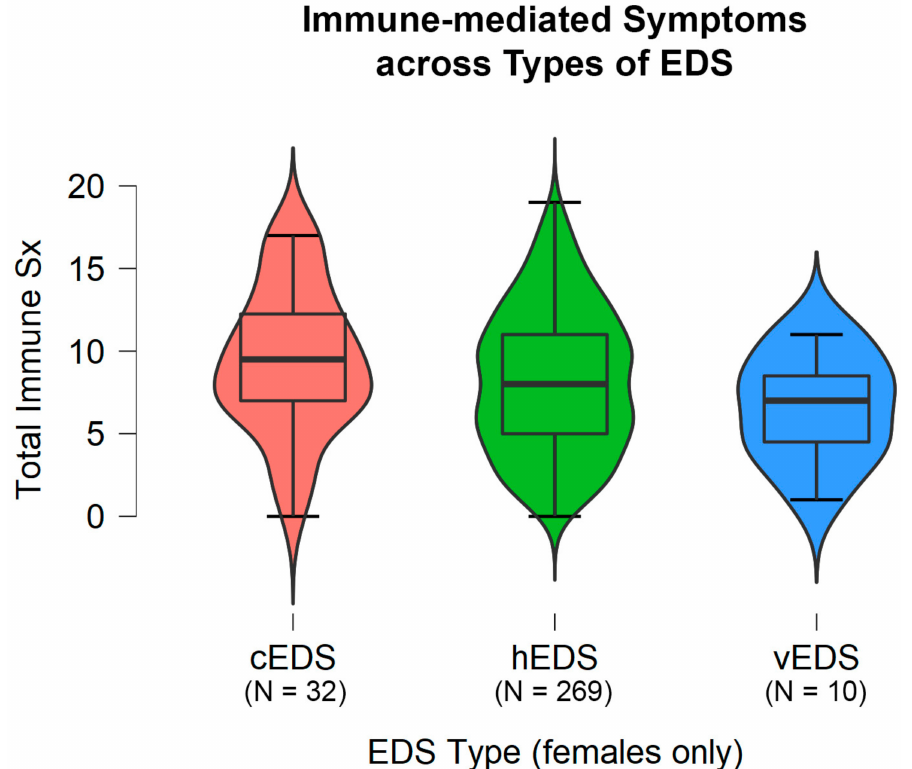
Figure 2. Violin plot indicating the number of reported immune-mediated symptoms across hypermobile EDS (hEDS), classic EDS (cEDS), and vascular EDS (vEDS). Data originally reported in Casanova et al., (2020). Only data for female participants were utilized for the analysis due to low numbers of males in the hEDS group, a condition that is extremely heavily sex skewed towards